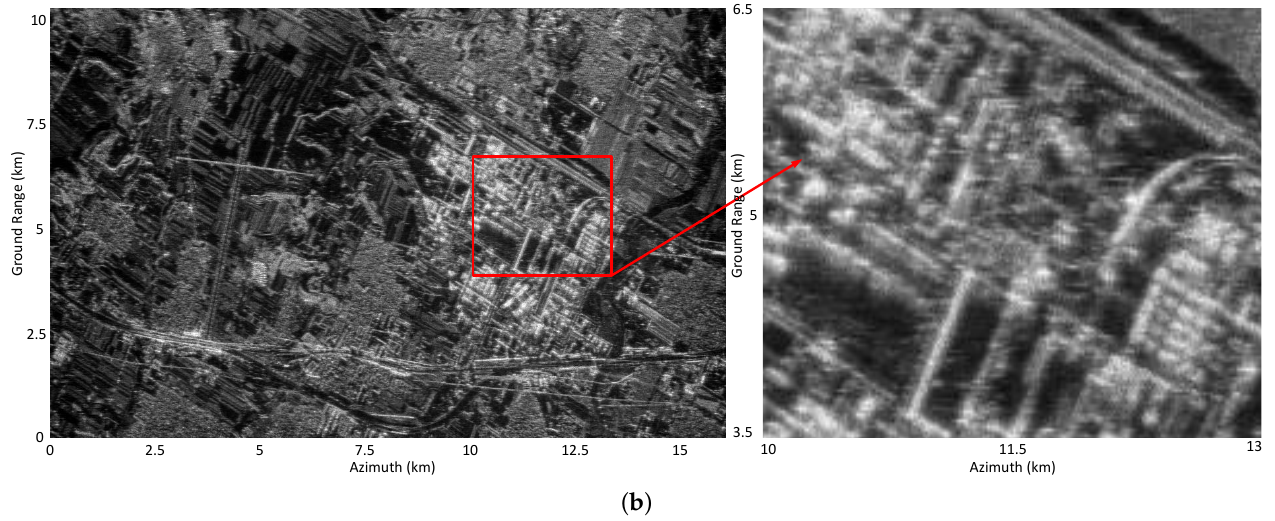
Figure 8. The original ( a ) and influenced ( b ) SAR images for the HH